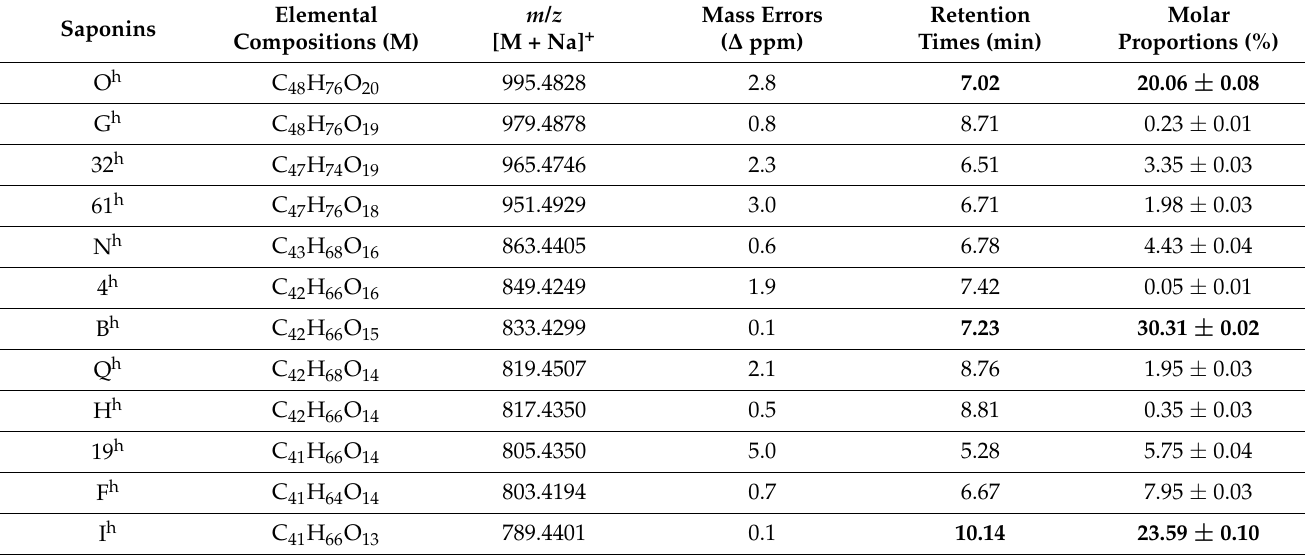
Table 2. Microwave-assisted alkaline hydrolysis (pH 10—150 ◦ C—5 min) of Chenopodium quinoa husk saponin extract: the elemental compositions of saponin ions are determined by MALDI-HRMS and the molar proportions (%) of the saponin ion are estimated based on the LC-MS signal relative